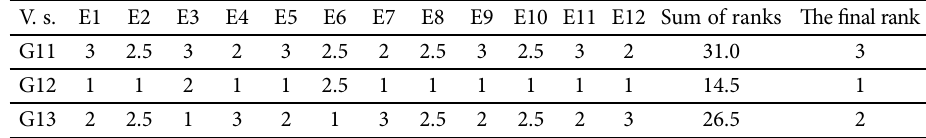
Table 9. Ranking factors in the group of a legal environment (for protected technology) regarding the commercial potential of